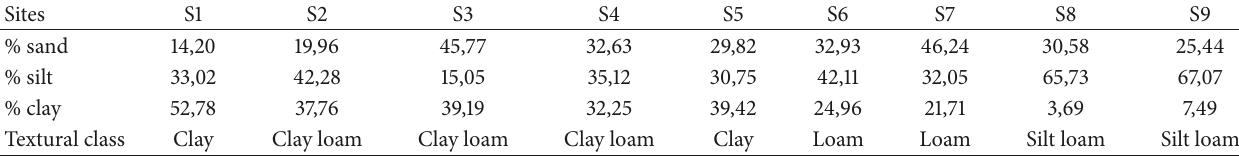
Table 3: Textural classification of soils from sampling sites in El Madher and Ouled Si Slimane areas.